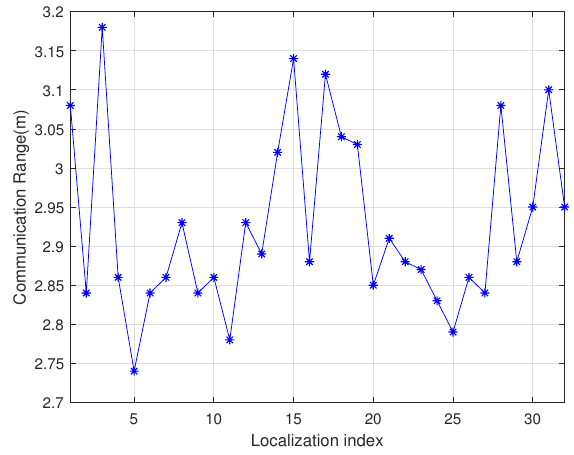
Figure 6. Sensor node communication range diagram.